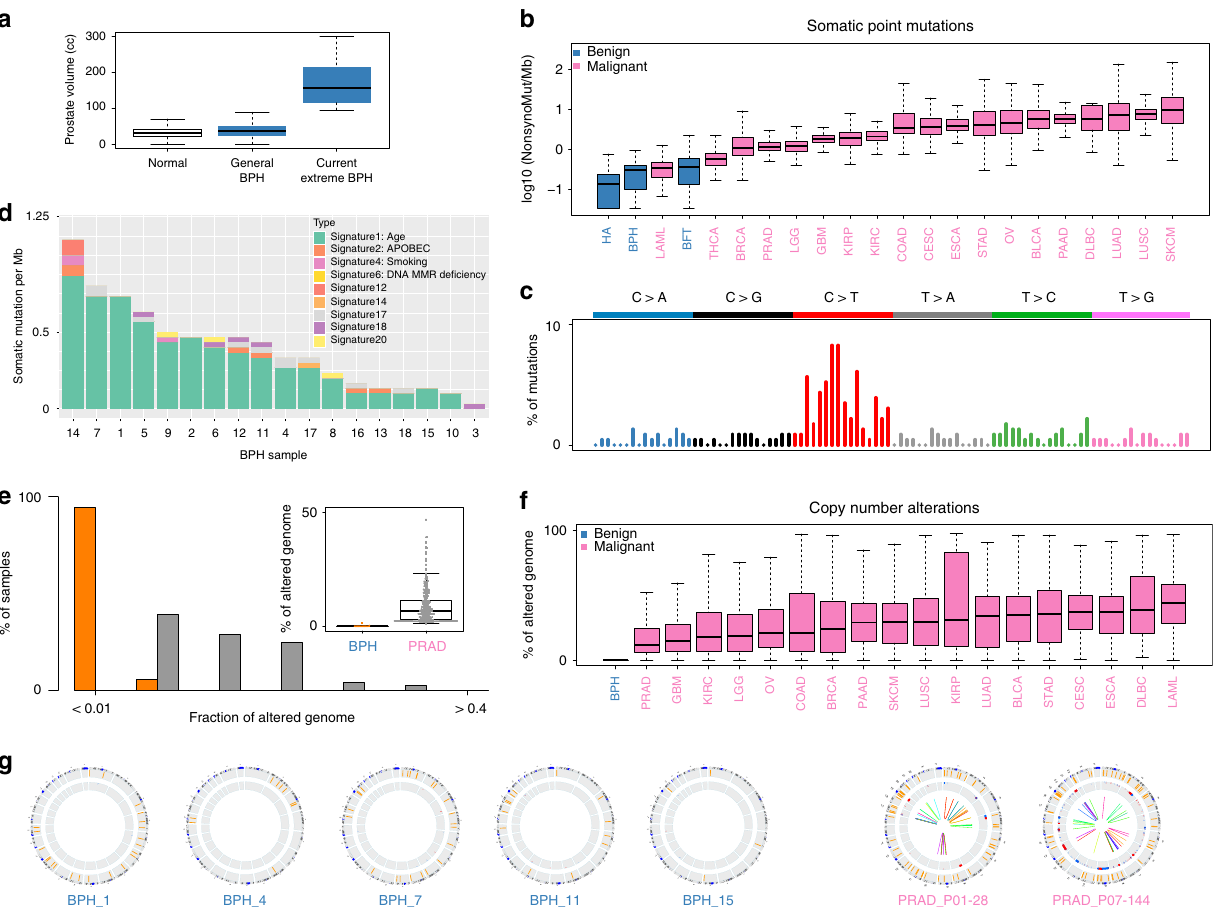
Fig. 1 Minimal genomic alterations are found in BPH samples. a Boxplots of prostate volume (cc) of normal ( n = 1427), general BPH ( n = 2950), and extreme BPH ( n = 18) cases used in the current study. b The prevalence of somatic non-synonymous mutations across benign disease and multiple cancer types. The y -axis represents the log10 value of mutations. The x -axis includes benign (blue) and malignant tumors (pink) from TCGA studies. BLCA ( n = 130); BRCA ( n = 988); CESC ( n = 40); COAD ( n = 216); DLBC ( n = 48); ESCA ( n = 184); GBM ( n = 282); KIRC ( n = 213); KIRP ( n = 113); LAML ( n = 196); LGG ( n = 533); LUAD ( n = 543); LUSC ( n = 178); OV ( n = 243); PAAD ( n = 185); PRAD ( n = 499); SKCM ( n = 472); STAD ( n = 289); THCA ( n = 504). HA: hepatocellular adenomas ( n = 46), and BFT: breast fi broadenomas ( n = 30). c The somatic mutation signatures of BPH. The signature is based on the 96 substitutions classi fi cation de fi ned by the substitution class and sequence context immediately 3 ’ and 5 ’ to the mutation position. The y-axis represents the percentage of mutations attributed to a speci fi c mutation type. The six types of substitutions are shown in different colors. d The contribution of mutation signatures to each BPH sample. Each bar represents a BPH case and y -axis denotes the number of somatic mutations per megabase. e The fraction of altered genome, partitioned into bins covering a range from <0.01 to ≥ 0.4, shown as a histogram for BPH and primary prostate cancer samples. Inset: boxplot of altered genome fraction for BPH samples ( n = 18) and primary prostate cancer ( n = 333) samples from TCGA study. f The lower fraction of altered genome in BPH (blue) when compared to malignant diseases (pink) from TCGA studies. BLCA ( n = 130); BRCA ( n = 988); CESC ( n = 40); COAD ( n = 216); DLBC ( n = 48); ESCA ( n = 184); GBM ( n = 282); KIRC ( n = 213); KIRP ( n = 113); LAML ( n = 196); LGG ( n = 533); LUAD ( n = 543); LUSC ( n = 178); OV ( n = 243); PAAD ( n = 185); PRAD ( n = 499); SKCM ( n = 472); STAD ( n = 289); THCA ( n = 504). g Circos plots of 5 BPH and 2 primary prostate cancer samples. The rings from outer to inner represent somatic coding mutations, copy number alterations and genomic rearrangements respectively. De fi nition of box plots in panels 1a, b, e and f: the center line represents median value, box limits represent 25% and 75% quantiles, and the top and bottom lines represent minimal and maximal values,